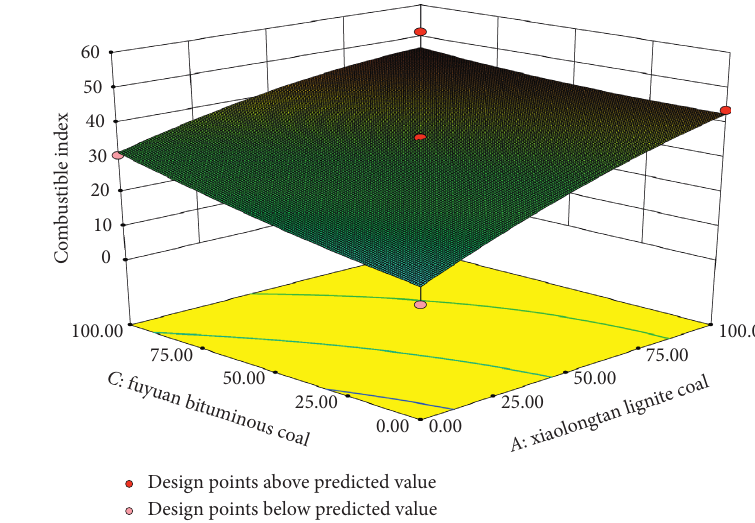
Figure 12: Response surface of the relationship between combustible index of mixing coals and mass ratios of Xiaolongtan lignite and Fuyuan bituminous